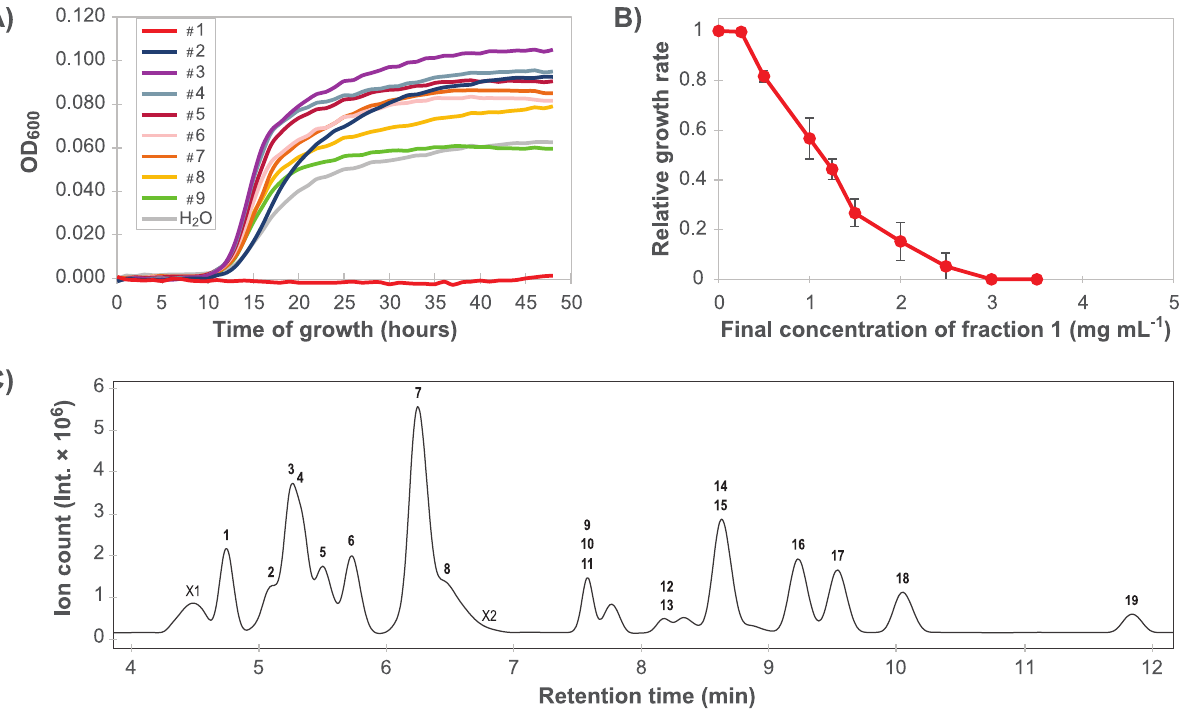
Fig 4. Identification and characterization of the anti-listerial fraction. A) L . monocytogenes MF1509 growth curves in the presence of HPLC fractions number 1 to 9 (see Fig 3). The experiment was performed once. B) Dose-response curve showing relative growth rates of L . monocytogenes as a response to increasing concentrations of fraction 1. Each point in the graph is an average of four (0, 1.25, 2.5 mg mL -1 ) or three (all other concentrations) independent data points. Error bars show the standard error of the mean. C) Base peak chromatogram after LC-MS separation of fraction 1. LC-MS/MS data for compounds in labelled peaks are presented in Table